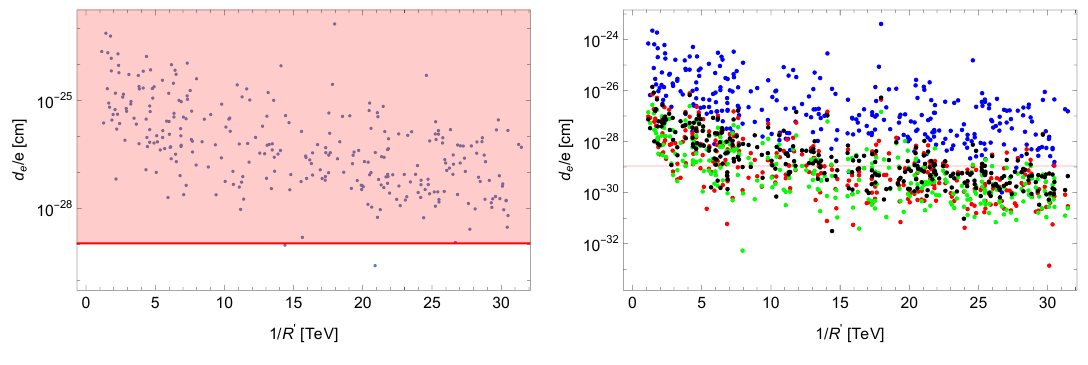
Figure 4 . Current constraints on the electron electric dipole moment, displayed together with the predictions of our scan (left), and relative size of the leptoquark (blue), Higgs (red), Z boson (green), and W boson (black) loop contributions (right), as a function of 1 /R 0